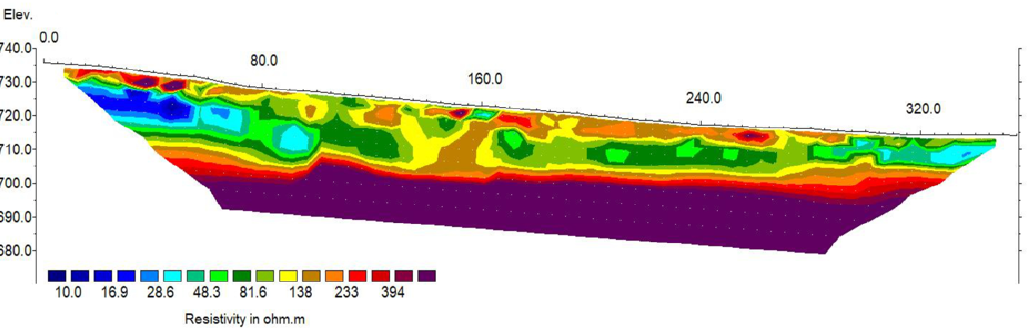
Figure 7. The modeled earth resistivity sections for APA02 ERT profile at the Site-D (road). Color bar presents resistivity values in ohm.m.